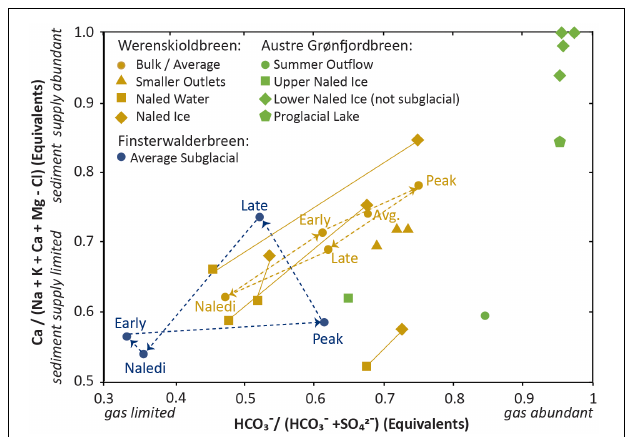
FIGURE 1 | Data from Svalbard. The x-axis is reflective of the contribution of carbonation vs. sulfur oxidation to the water chemistry. Oxidation becomes more prevalent in gas-limited systems. The y-axis is reflective of the relative contribution of calcite. As a highly reactive mineral constituent, calcite becomes depleted in sediment limited systems. Seasonal progression at a single outlet is marked with a dashed line. In the Werenskioldbreen data, ice, and water from the same naled are connected with a solid line. The data from Werenskioldbreen and Finsterwalderbreen represents seasonal or multi-sample averages; data from Austre Grønfjordbreen represents single